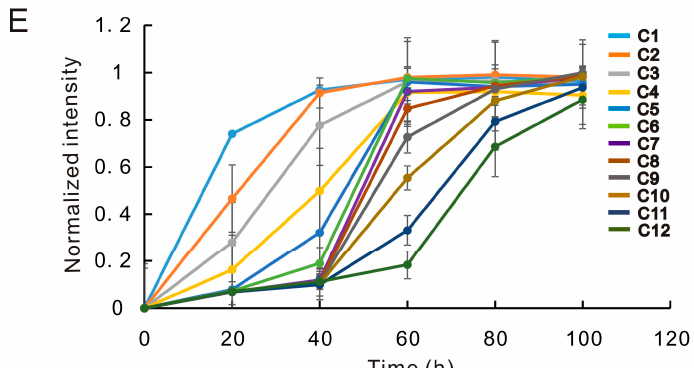
Figure 3. Demonstration and characterization of solution exchange in μ HD chip. ( A – C ) Photographs showing the solution replacement process (blue dye replacing DI water) at 0 min, 60 min and 100 min, respectively. Scale bar = 1 mm; ( D ) photograph of the whole chip taken at 80 min after the replacement process started. Scale bar = 4 cm; ( E ) the relationship between the normalized intensity of the blue dye solution and the time after the replacement process started.